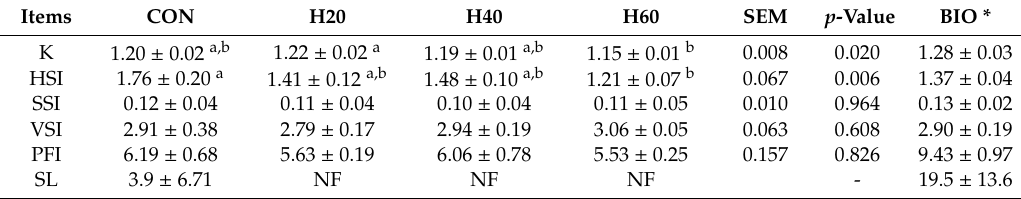
Table 5. Condition factor (n = 45), somatic indices and occurrence of splenic lipidosis (n = 90) of Eurasian perch juveniles fed experimental diets and the commercial control diet (mean ±